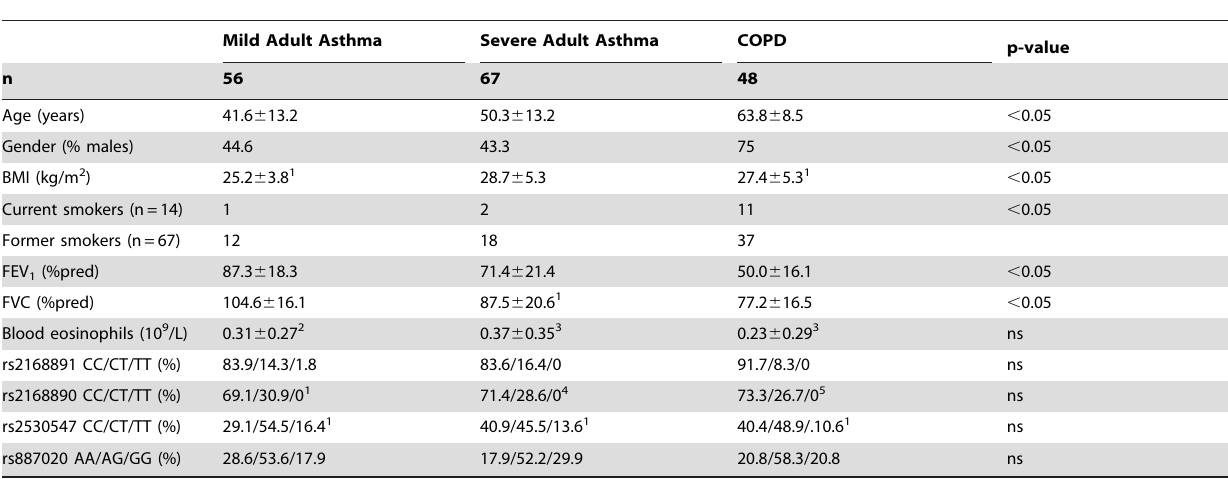
Table 1. Characteristics of the BIOAIR study population (n=